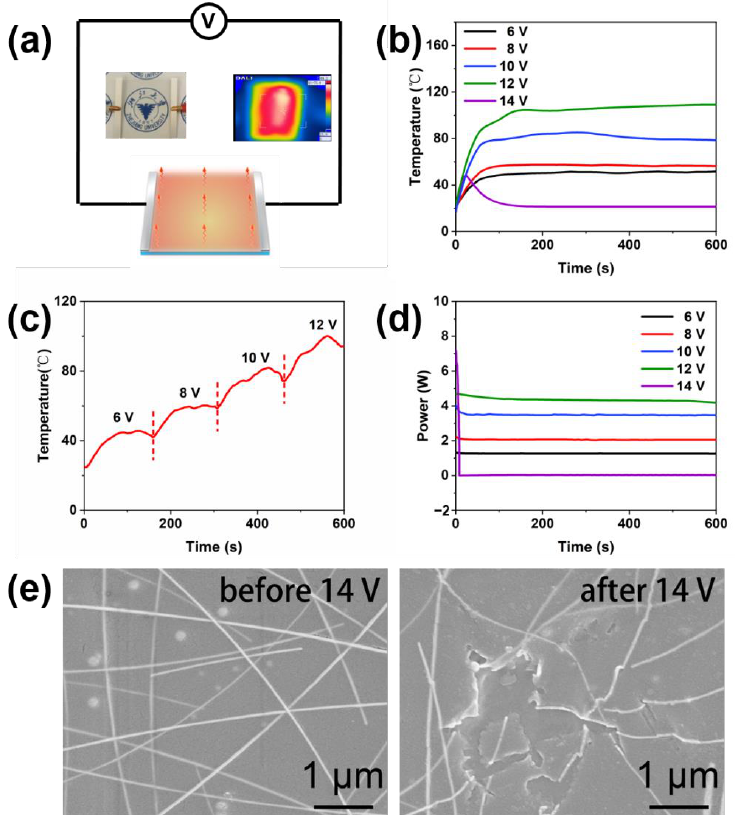
Figure 7. ( a ) The schematic illustration and the infrared image of the AgNW film heater (5 cm × 5 cm). ( b , c ) Temperature-time profile at different applied voltages. ( d ) Power-time profile at different applied voltages. ( e ) SEM images of the AgNW heater before and after an applied voltage of 14 V.